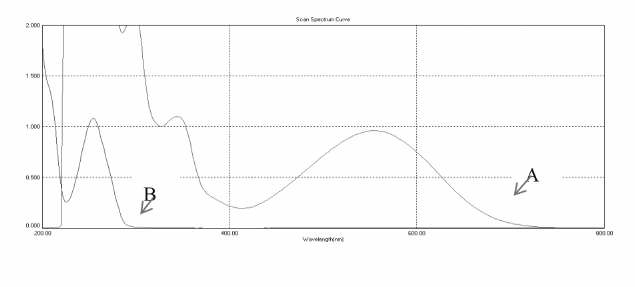
Figure 3 - (A) the maximum absorption for dye (methyl blue), (B) the maximum absorption for